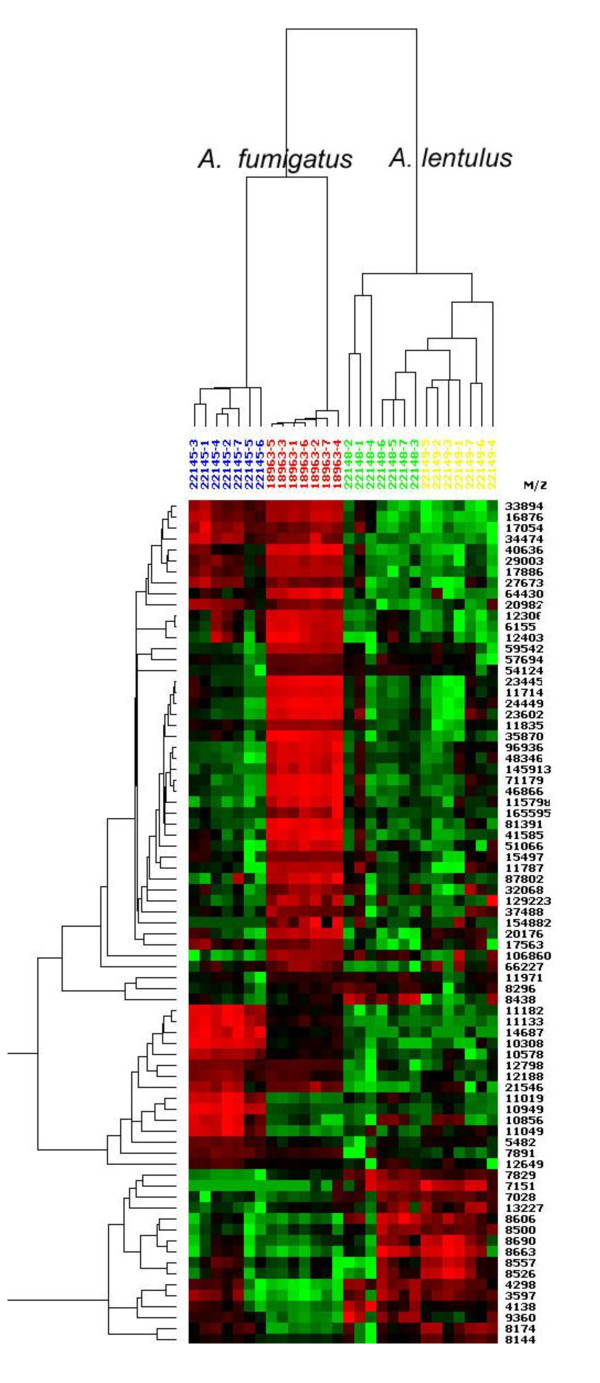
The hierarchical clustering of A. fumigatus and A. lentulus metabolic extracts. (shaken culture, modified Sabouraud medium at 37°C, on CM10 ProteinChips®) showing 77 out of 101 significant p values (p < 0.01). From the right to the left: in red and blue colour A. fumigatus (strains IHEM 22145 and IHEM18963) and in green and yellow colour A. lentulus (strains IHEM 22148 and IHEM 22149).